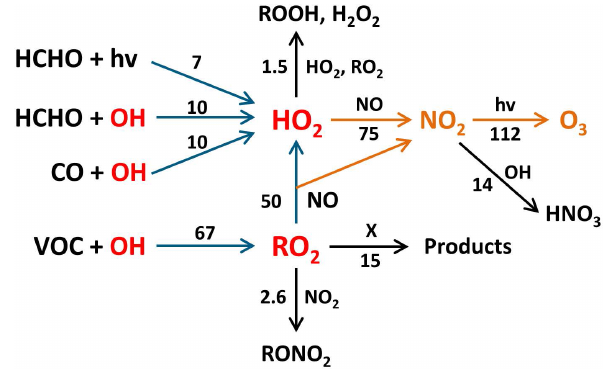
Figure 5. Main reaction pathways leading to photochemical net ozone formation during the Heshan campaign. Blue arrows show the reaction paths leading to RO 2 and HO 2 , and yellow arrows in- dicate the oxidation reactions of NO to NO 2 by peroxy radicals with subsequent NO 2 photolysis yielding ozone. Black arrows rep- resent reactions that remove peroxy radicals or NO 2 and thus reduce ozone production. Numbers represent median daily integrated reac- tion rates (ppbv) calculated by Eq. (12). The value for VOC + OH corresponds to k OH ( VOC(2) ) ×[ OH ] (see Eq. 8). The reaction with X indicates an unknown process that removes RO 2 without produc- ing NO 2